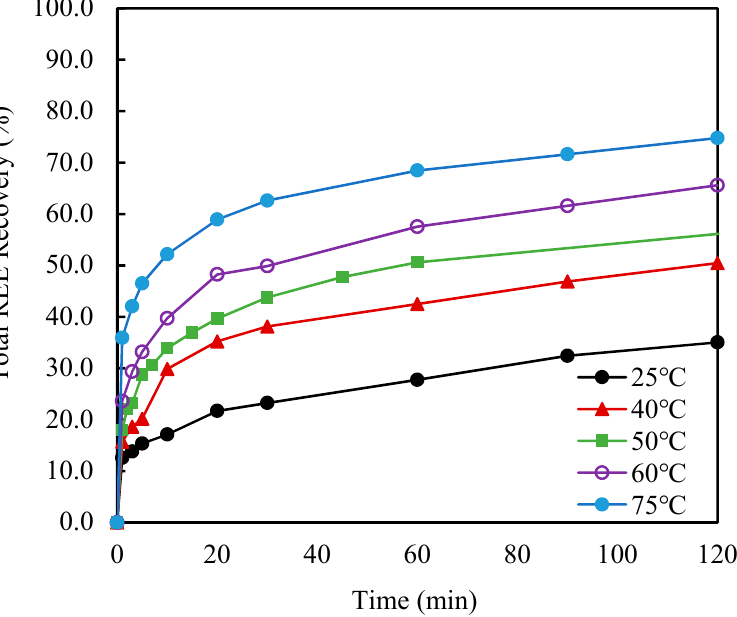
Figure 10. Effect of leaching reaction temperature on the leaching recovery of total rare earth elements contained in the Fire Clay coal middling (1 M H 2 SO 4 , 530 rpm, S/L = 10g/L, D 80 = 8.7 μ m).